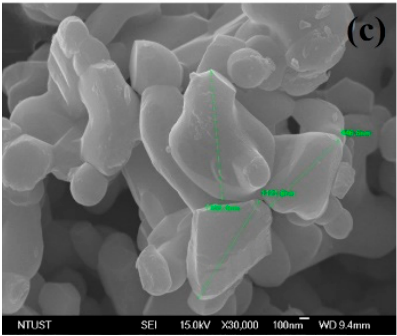
Figure 5. FE-SEM images of Fe 2 O 3 at different calcination temperatures ( a ) 500 °C ( b ) 700 °C ( c ) 900 °C.